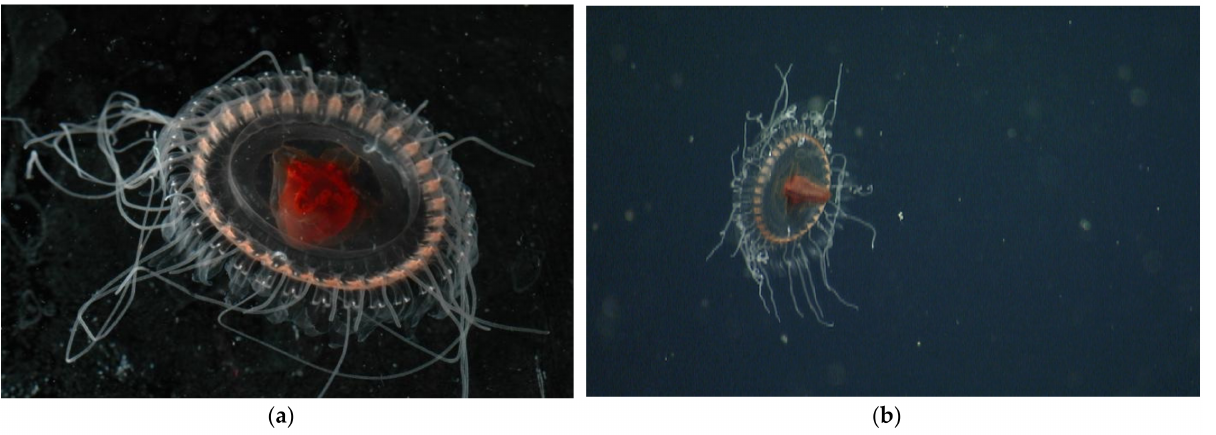
Figure 3. ( a ) Laboratory photo of Atolla species B (photo by Rob Sherlock) of the specimen collected on 14 April 2007 (T1088). ( b ) In situ image of Atolla species B (T1088) photographed on 14 April 2007 at a depth of 2570